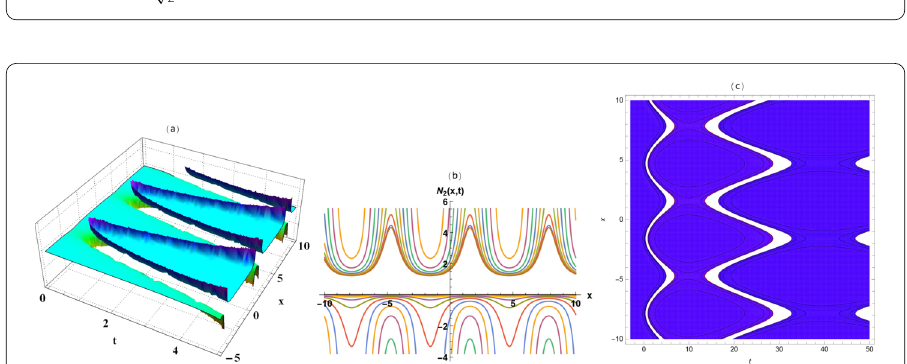
Figure 2 Solitary wave of Eq. (6) in three distinct plots (three- and two-dimensional and contour plot) when [ δ = 5, k = 1 √ , ρ = –1, σ = 1, ω = – 3 , (cid:13) = 2 2